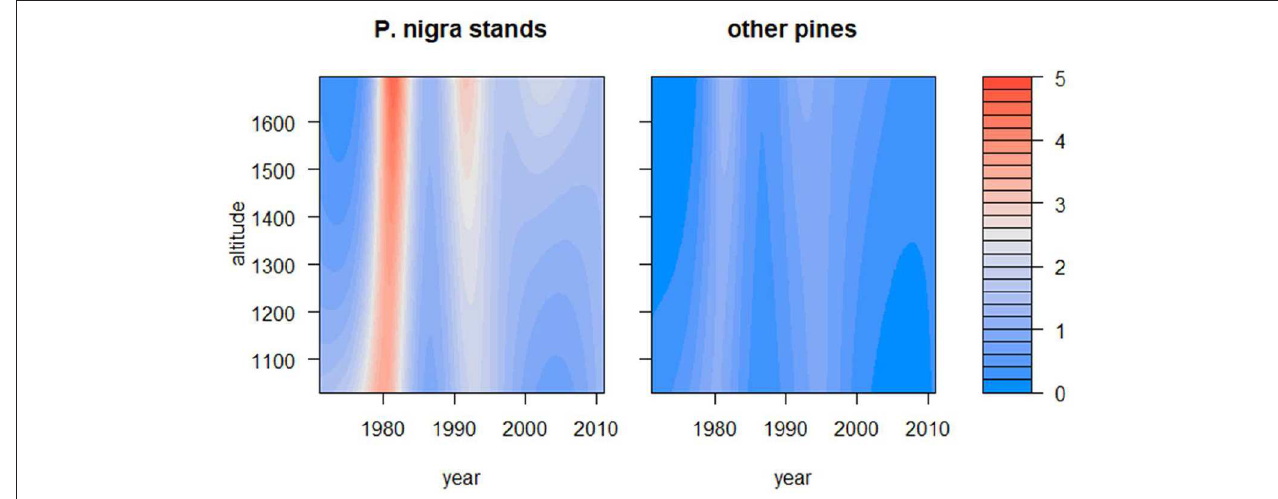
FIGURE 3 | Temporal changes in pine processionary moth (PPMD) as a function of altitude (y axes, in m) in P. nigra stands and in stands dominated by other pine species according to the results of the GAMM. The PPMD varies from 0 to 5.